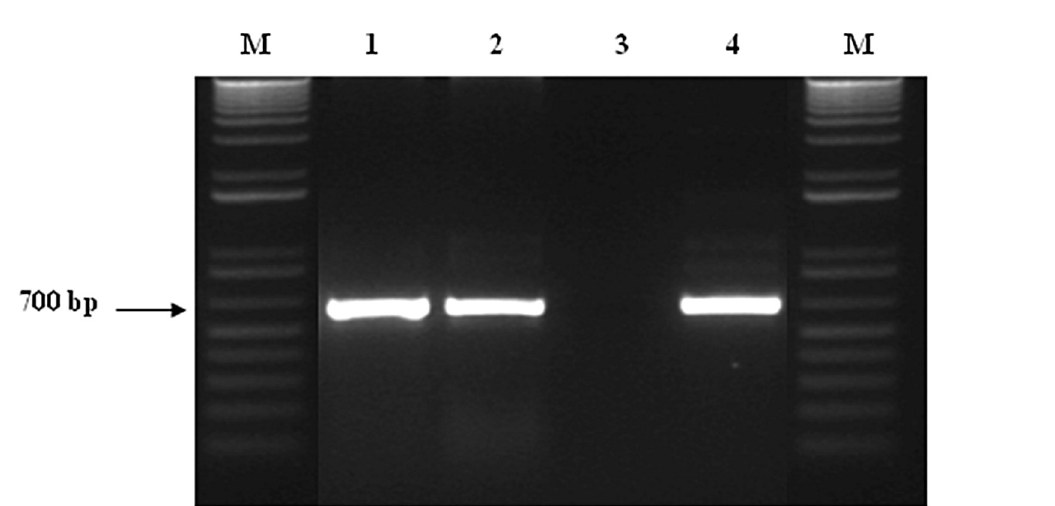
Figure 3. Amplification products from Burkholderia spp. obtained using LP1 and LP4 primers. Lane M, 1 Kb plus DNA ladder (Invitrogen); lane 1, type strain B. gladioli pv. gladioli CFBP 2427; lane 2, B. g. pv. alliicola CFBP 2422; lane 3, SDW; lane 4, band produced by group A and group B saffron isolates.